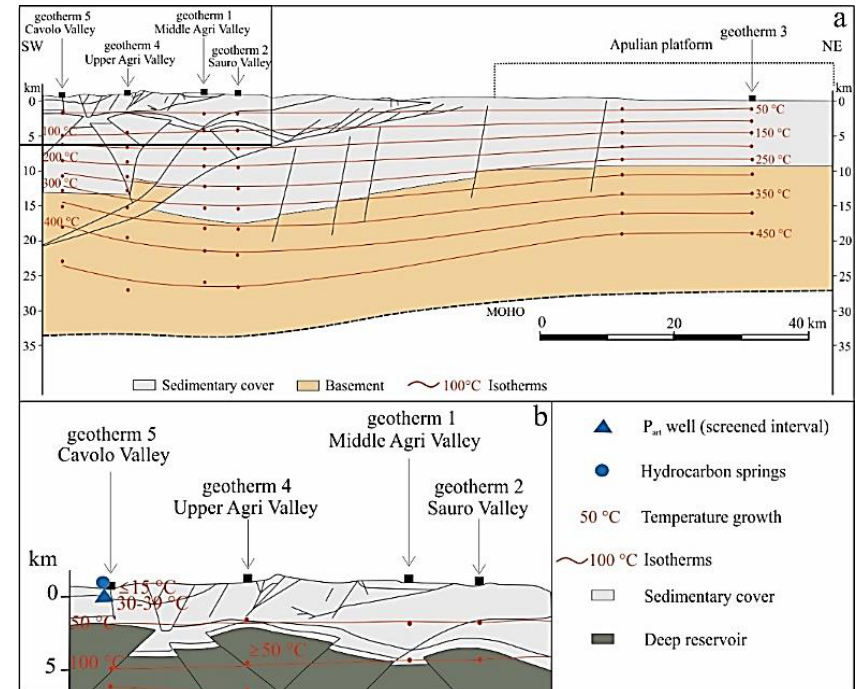
Figure 8. ( a ) Geological cross-section showing isotherms obtained from the interpolation of geothermal profiles through third-degree polynomials. Red dots show temperatures along the geotherm profiles (50 °C steps). ( b ) Detail of Figure 8a. Numbers in red show the growth temperature ranges of psychrophilic, mesophilic, and thermophilic microorganisms. Springs (blue point), the well P art (blue triangle), and the deep reservoir (in grey) are shown (from Candela et al. 2015, modified [98]).